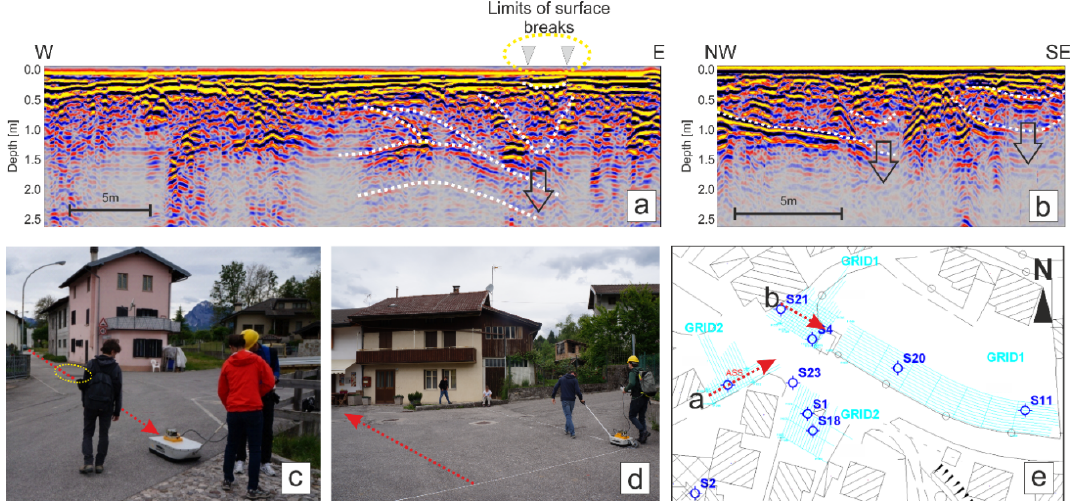
Figure 13. Exemplary 2D processed and interpreted 2D GPR profiles ( a , b ). On ( c , d ) photographs, the paths of profiles in ( a , b ) are highlighted, respectively. ( e ) Location map of the profiles in ( a , b ). Dotted white lines mark down-dipping layers related to the presence of sinkhole phenomena; black arrows are located where the deformation reaches the maximum; dotted yellow ellipses on ( a , c ) show the area where breaks at the surface are apparent.